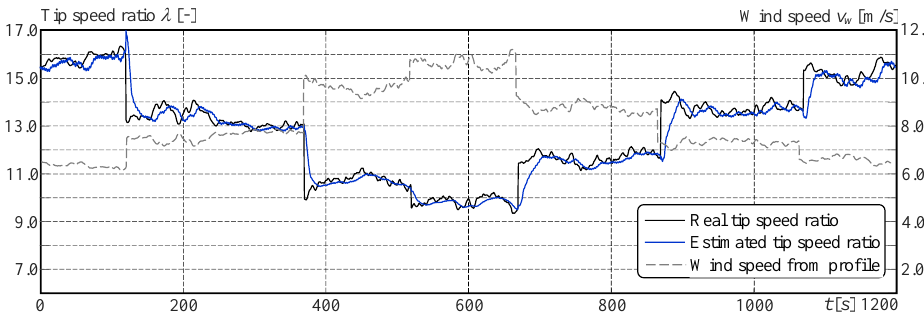
Figure 9. Time series of the tip-speed ratio.